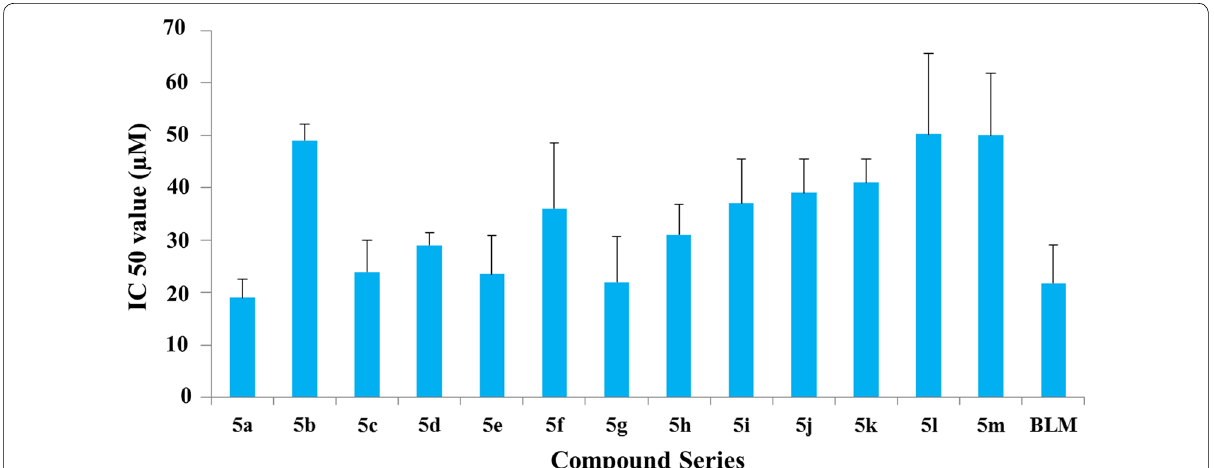
Fig. 3 In vitro cytotoxicity analysis of synthesized compounds 5 ( a – m ) and bleomycin against FaDu hypopharyngeal cancer cells after 48 h incubation. The data are presented as the mean SD of four replicates each. The graph shows the IC 50 values of the synthesized compounds and ± bleomycin